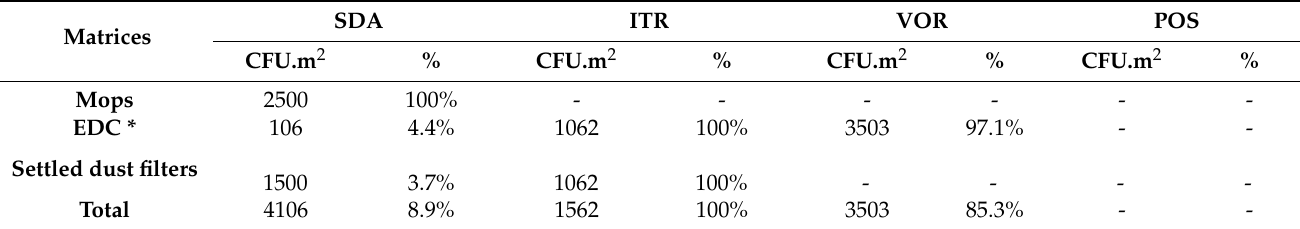
Table 4. Prevalence of Aspergillus section Fumigati among Aspergillus sp. in azole-supplemented SDA media.